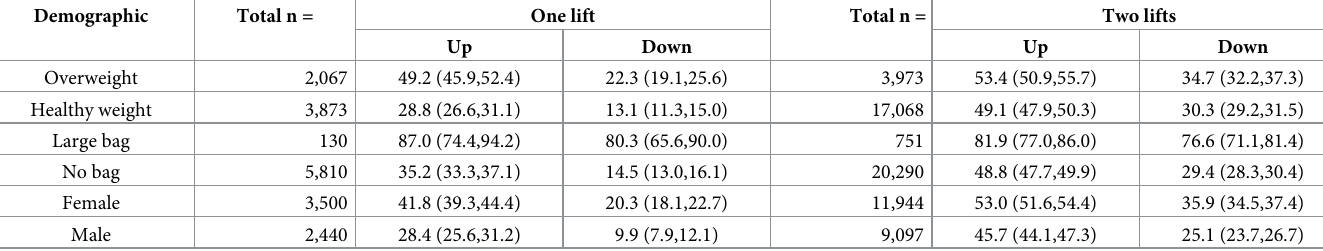
Table 2. Percentage avoidance of stairs (95% CI) a by lift number, direction of travel and demographic group.